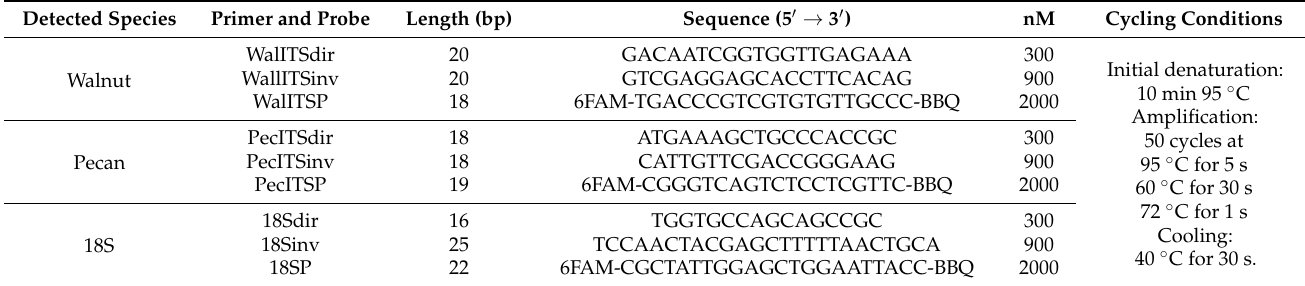
Table 1. DNA sequences and description of the pecan (AF303825) and walnut (HE574850) primers and probes to develop a real time PCR